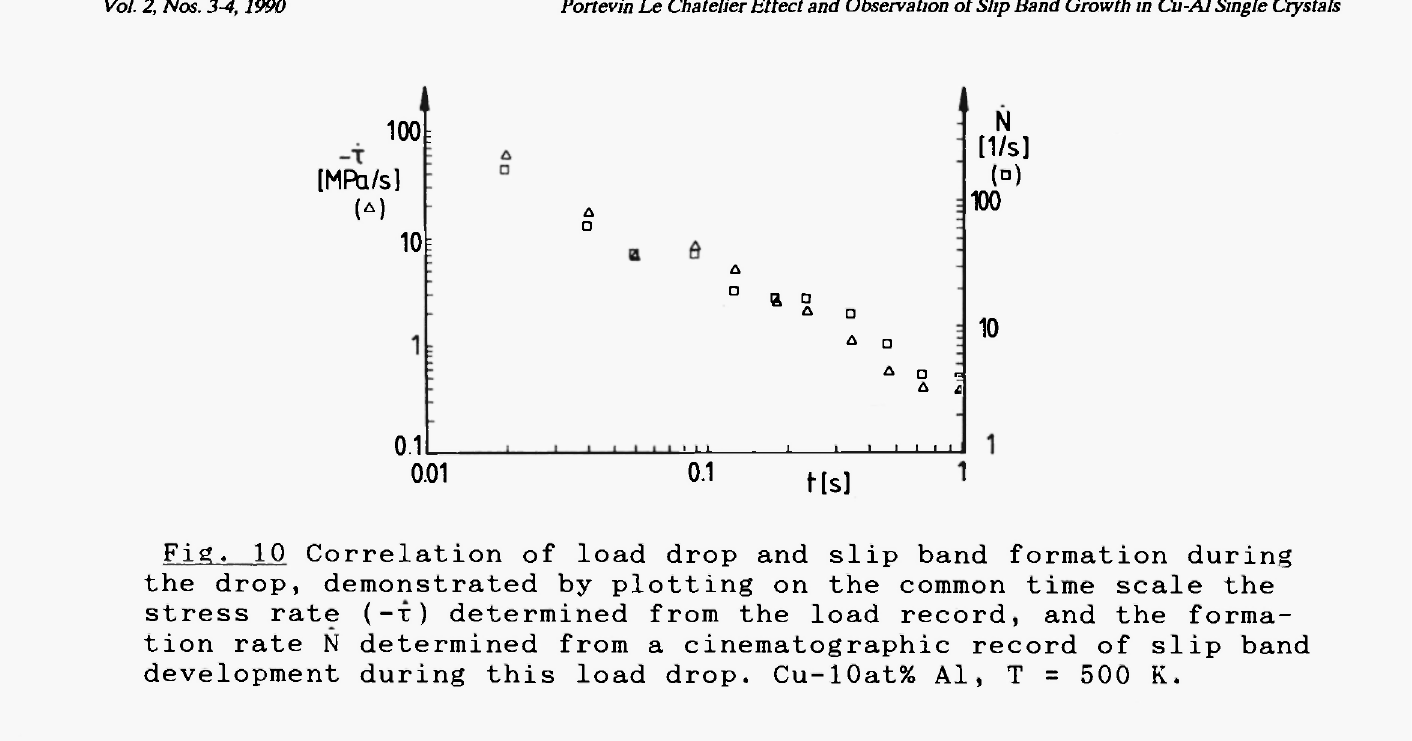
Fig . 10 Correlation of load drop and slip band formation